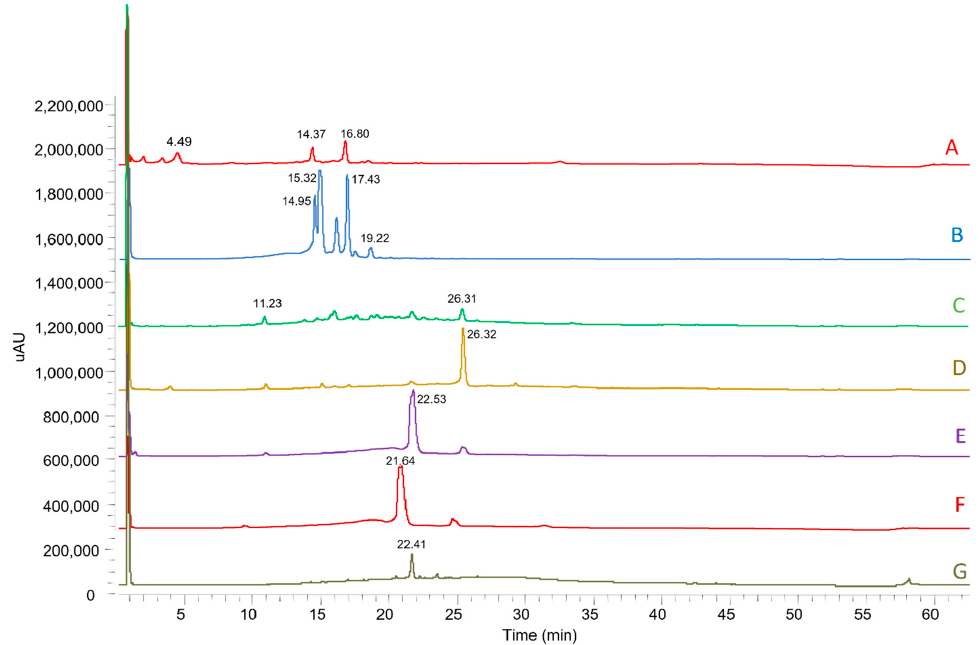
Figure 2. Chromatograms of the subfractions MMEAF-A–G analyzed by UHPLC-DAD-ESI-MS n and monitored at 254 nm. Table 1. Retention time (Rt), UV spectra, and MS/MS data of the compounds identified in the MMEAF subfractions (MMEAF-A-G). Nº